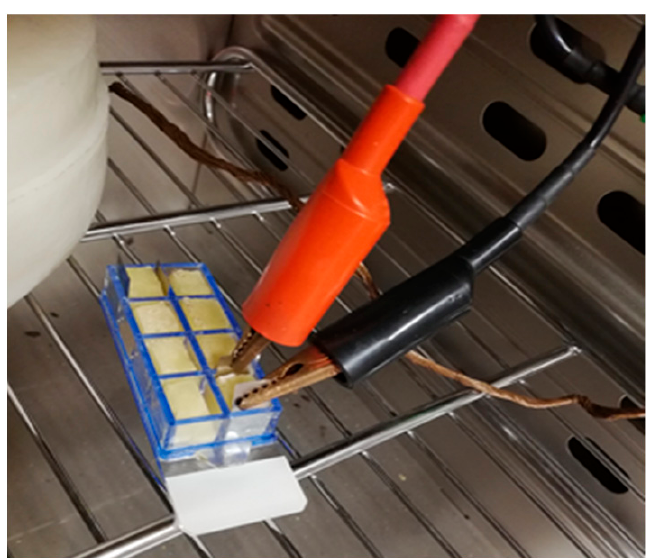
Figure 2. Samples under DC standard test.